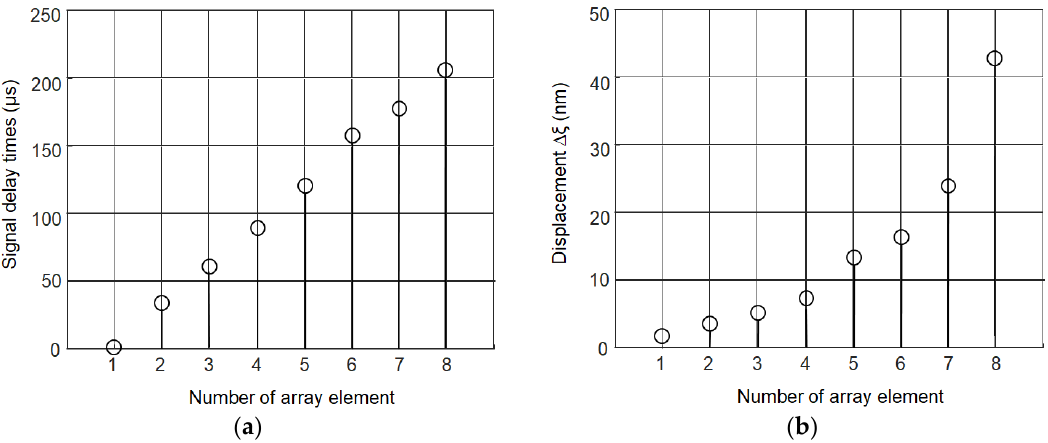
Figure 6. Optimization of excitation of the air-coupled ultrasonic array: ( a ) delay times of the excitation instants of different array elements; and ( b ) normal displacements of the PVC film versus the number of excited array elements.